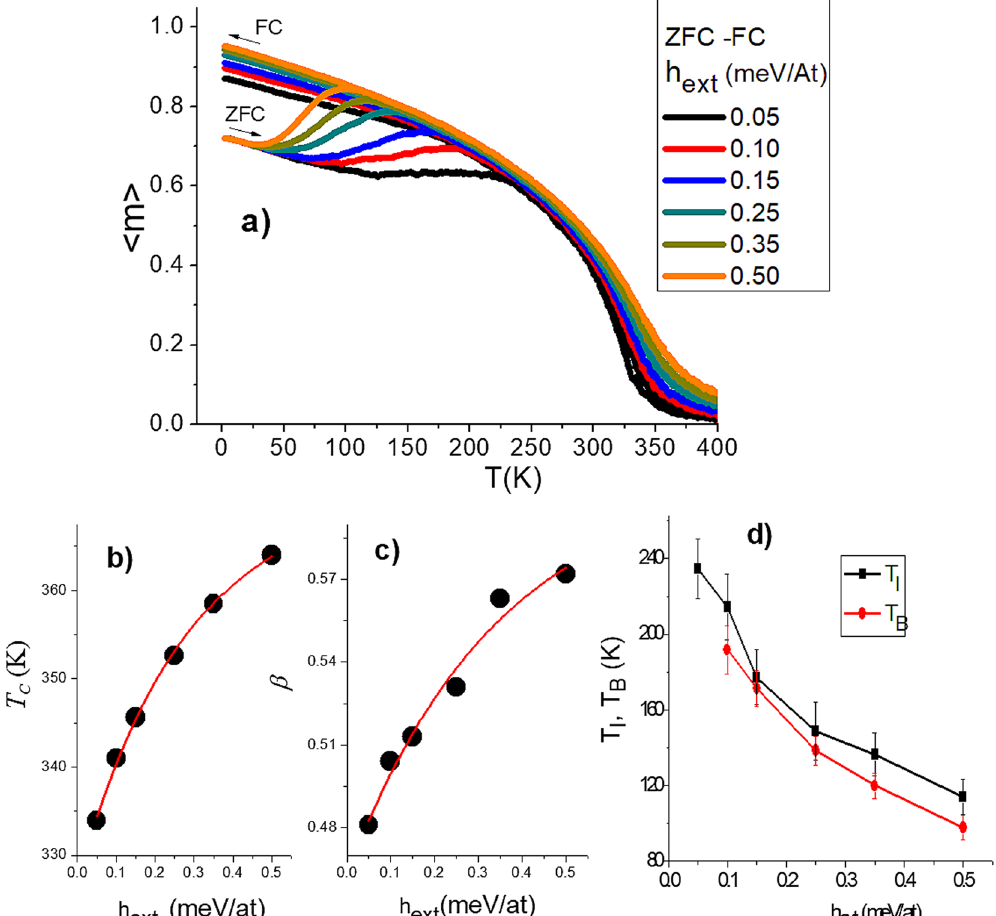
Figure 4. ( a ) ZFC-FC curves for different values of external magnetic field. Dependences with h ext of the transition temperature and the critical exponent β are shown in ( b ) and ( c ) respectively. ( d ) Behavior of the irreversibility and blocking temperatures with the external